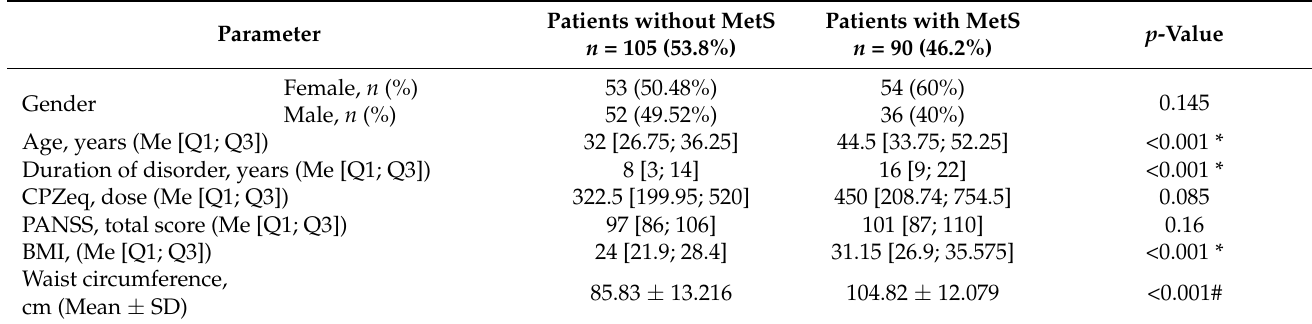
Table 1. Demographic and clinical parameters of the studied patient groups. Parameter